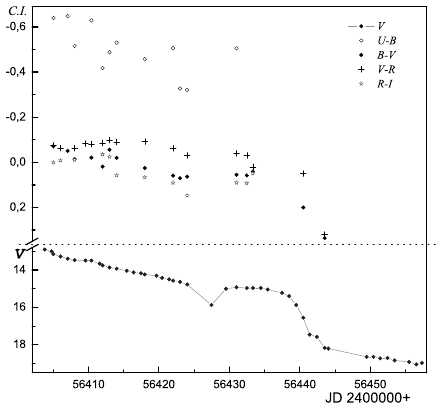
Figure 2: Mean V light curve and colour indices curves of superoutburst.